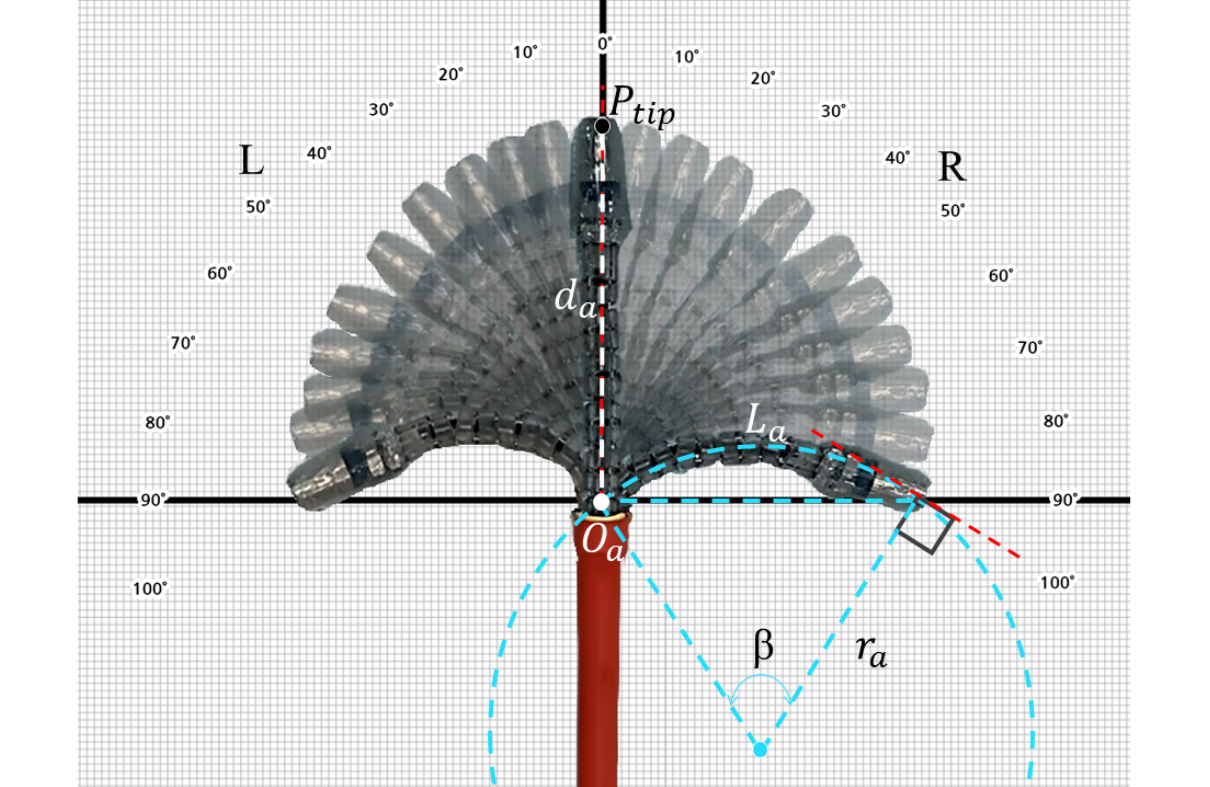
Figure 9. Experimental composite image showing the articulating range of the articulating module. The radius of curvature reaches 74.5 mm, and angle extends to 100°.